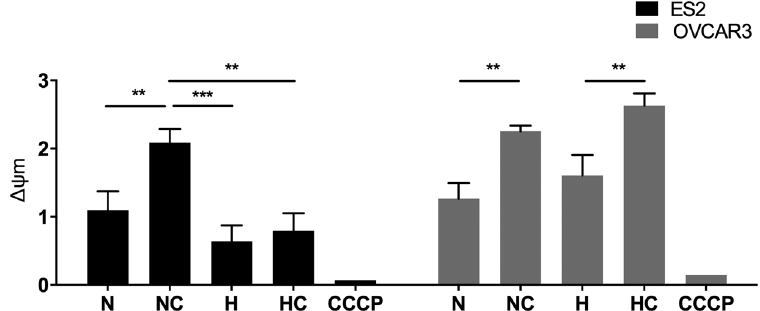
Figure 3. Mitochondrial membrane potential under normoxia and hypoxia with and without cysteine, in ES2 (OCCC) and OVCAR3 (OSC) cells. Quantification of Δψ m expressed as a ratio of red/green fluorescence intensity ratio in the different treatments (ratio of geometrical means) for ES2 and OVCAR3 cell lines for 16 h of assay. CCCP is a positive control for depolarization. N – Normoxia; NC – Normoxia supplemented with cysteine; H – Hypoxia; HC – Hypoxia supplemented with cysteine. Results are shown as mean ± SD. * p < 0.05, ** p < 0.01, *** p < 0.001 (One-way ANOVA with post hoc Tukey